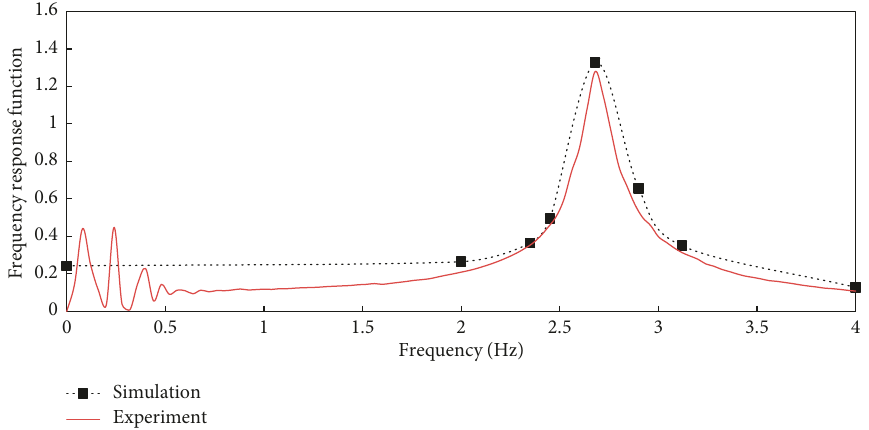
Figure 8: Frequency responses of the model offshore platform under sweep wave.